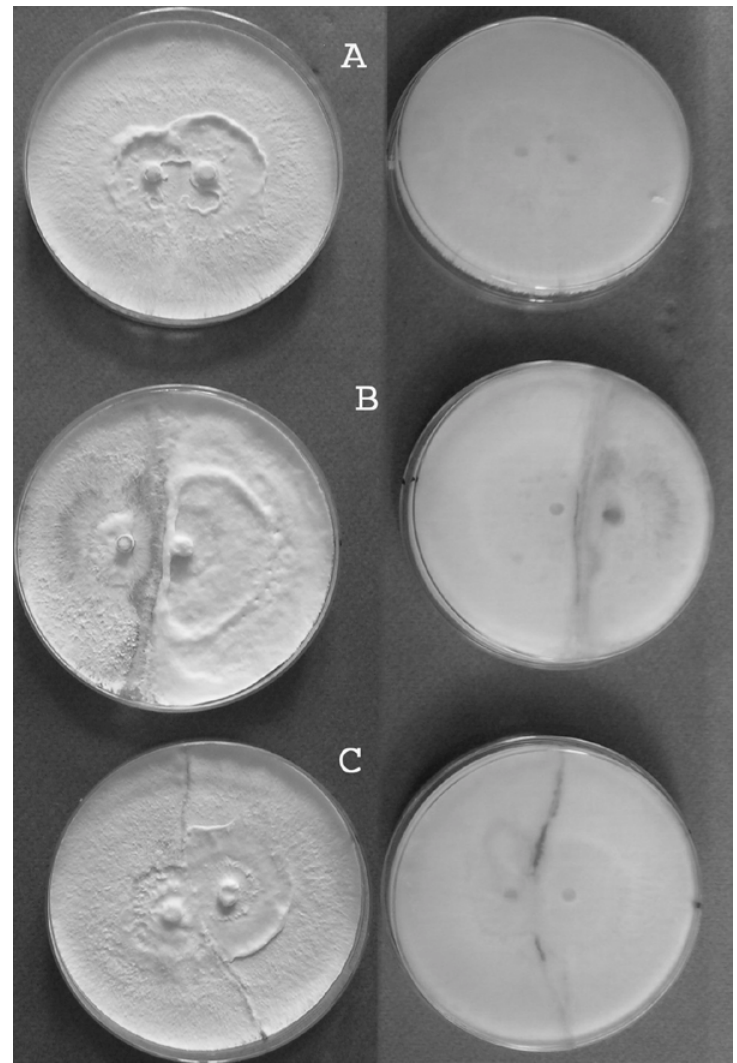
Figure 3. Examples of somatically compatible (self-pairing) (A) and incompatible (B and C) reactions between paired iso- lates of Ganoderma adspersum